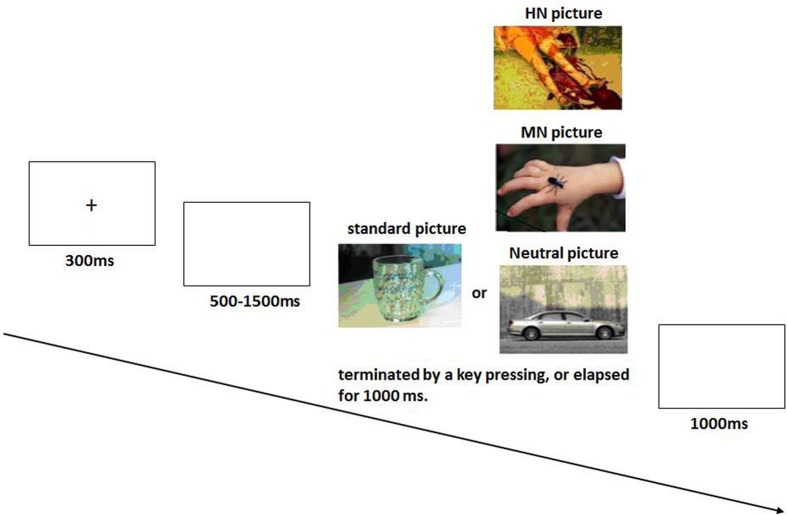
The diagram of our experimental task (Yuan et al., 2015).